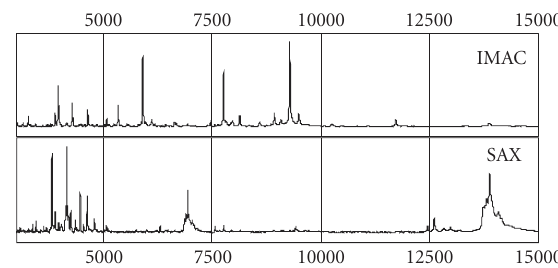
Figure 1. Protein spectra of one serum sample processed on the IMAC metal binding chip array and on the positively charged SAX chip array. Note that several di ff erent proteins are captured by the two di ff erent chip